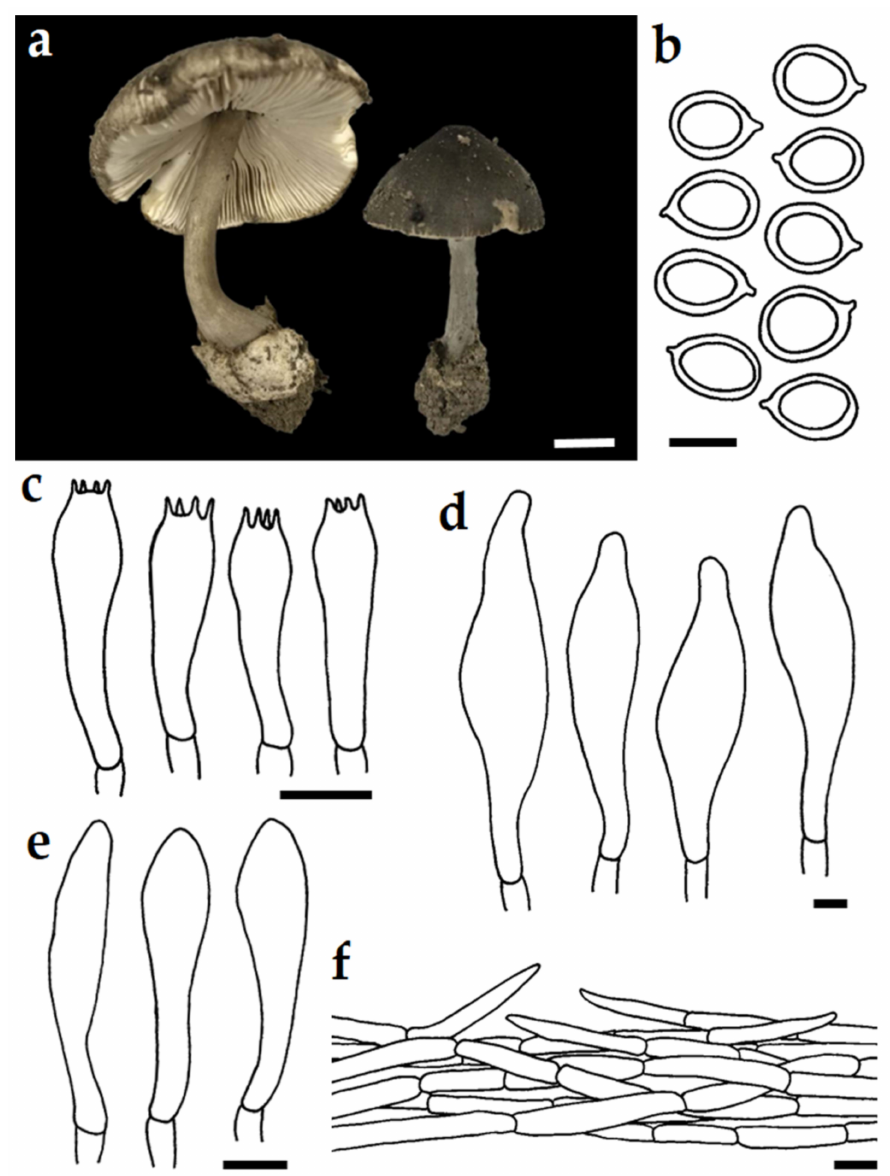
Figure 3. Volvariella thailandensis SDBR-CMUNK0957 (holotype). Basidiomata ( a ); Basidiospore ( b ); Basidia ( c ); Pleurocystidia ( d ); Cheilocystidia ( e ); Pileipellis terminal elements ( f ). Scale bars: ( a ) = 10 mm; ( b ) = 5 µ m; ( c – f ) = 10 µ